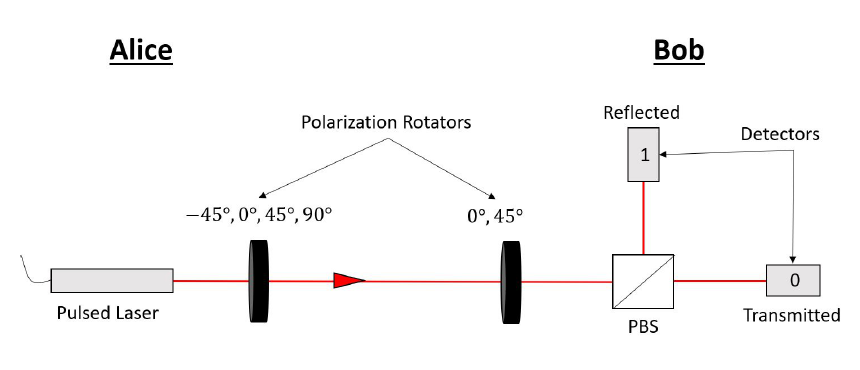
Figure 2. Optical diagram with the bases + (0 ◦ and 90 ◦ ) and x ( − 45 ◦ and 45 ◦ ). "PBS" defines the polarizing beam-splitter.